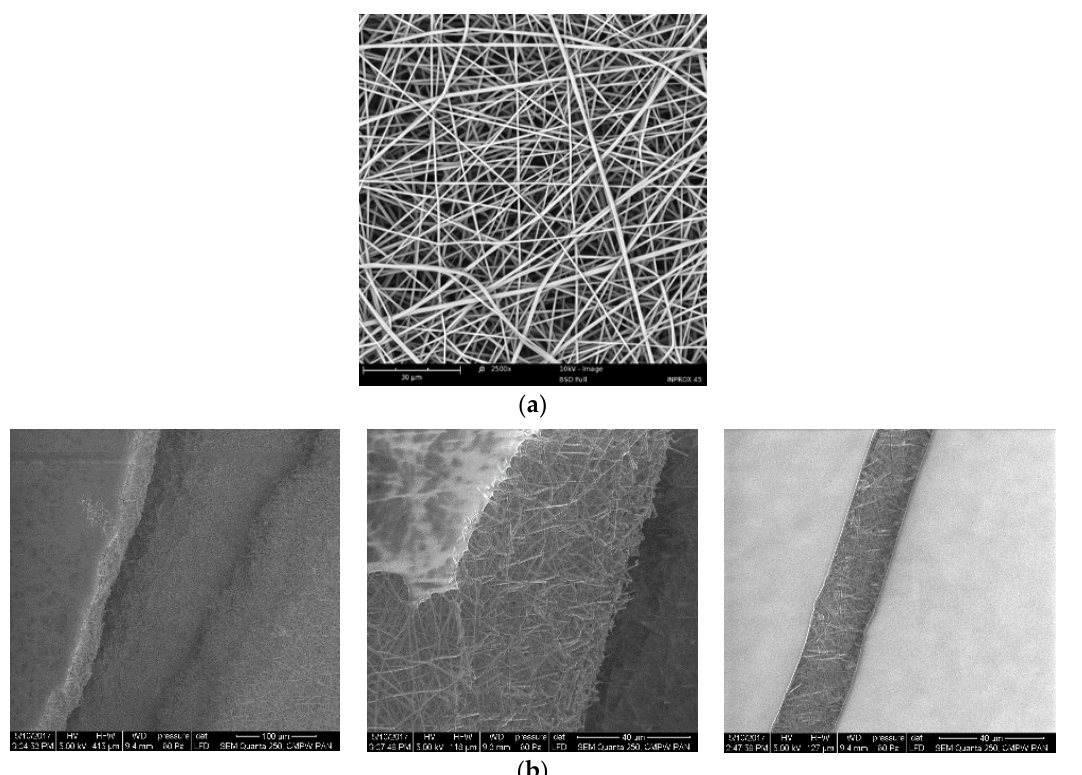
Figure 2. SEM micrographs of the P(iPrOx-nPrOx) mat: ( a ) in the dry state; and ( b ) after incubation in water at 40 °C for 2 h.